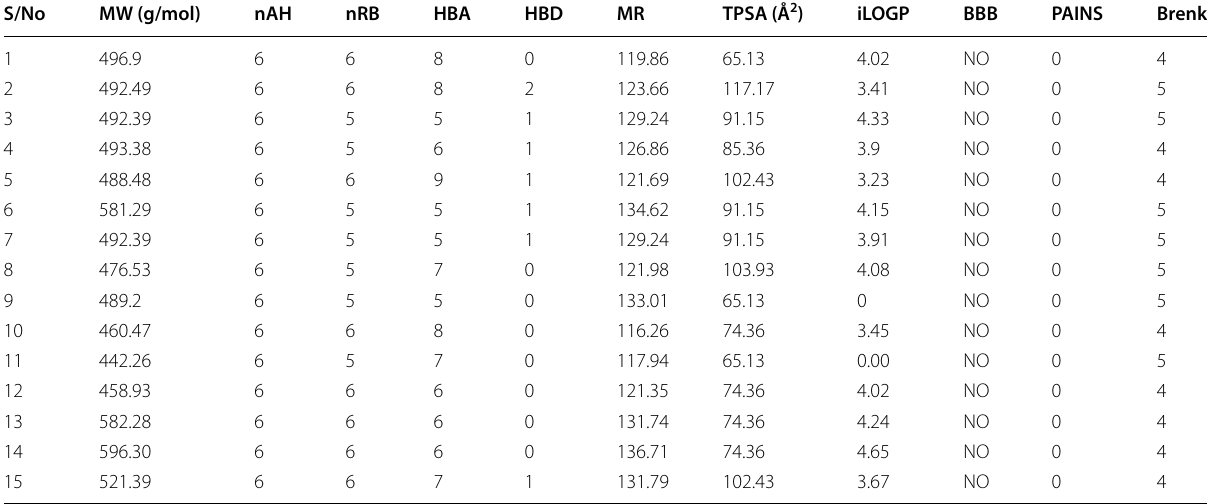
Table 14 Physicochemical and ADME properties (pharmacokinetics) of designed parthenolide compounds against the MDA-MB-231 cell